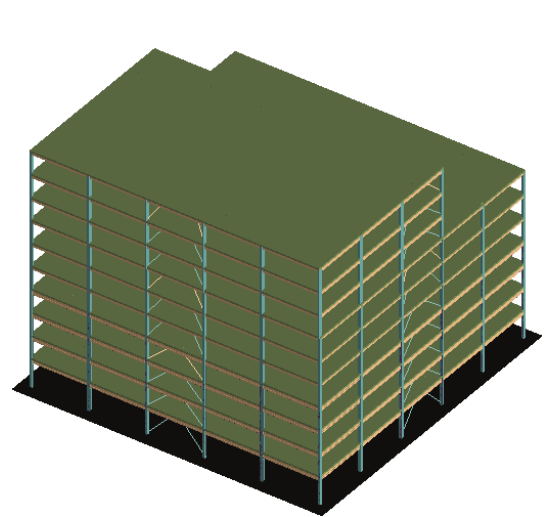
(C) Fig. 2. Vertically irregular MRF, CBF, and EBF